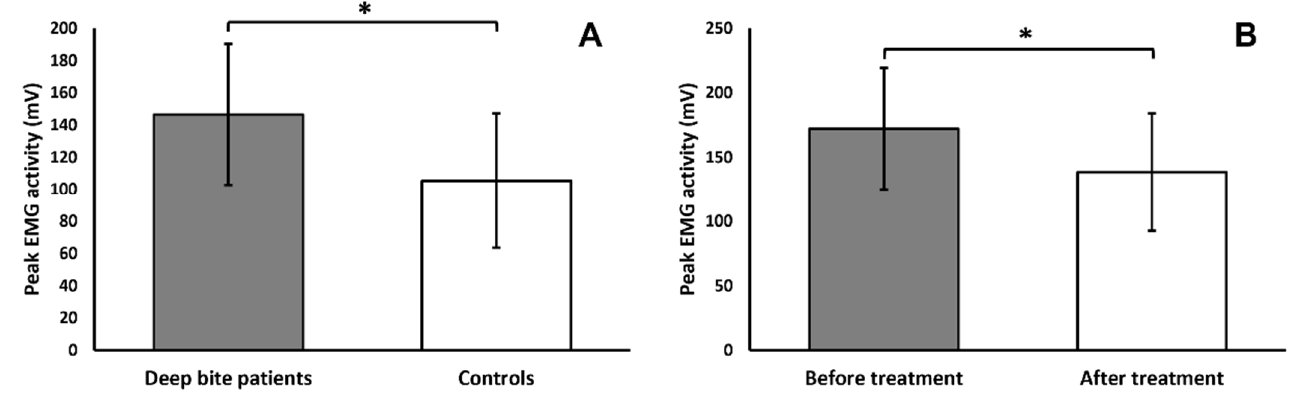
Figure 4. ( A ) Peak EMG amplitude of masseter and temporalis anterior (data merged) in deep bite patients compared to controls, showing significantly higher activity associated with malocclusion. ( B ) Peak EMG activity of masseter and temporalis anterior (data merged) in deep bite patients, before and after treatment with FGB, showing a significant reduction in muscular activity after correction of the malocclusion. * p <